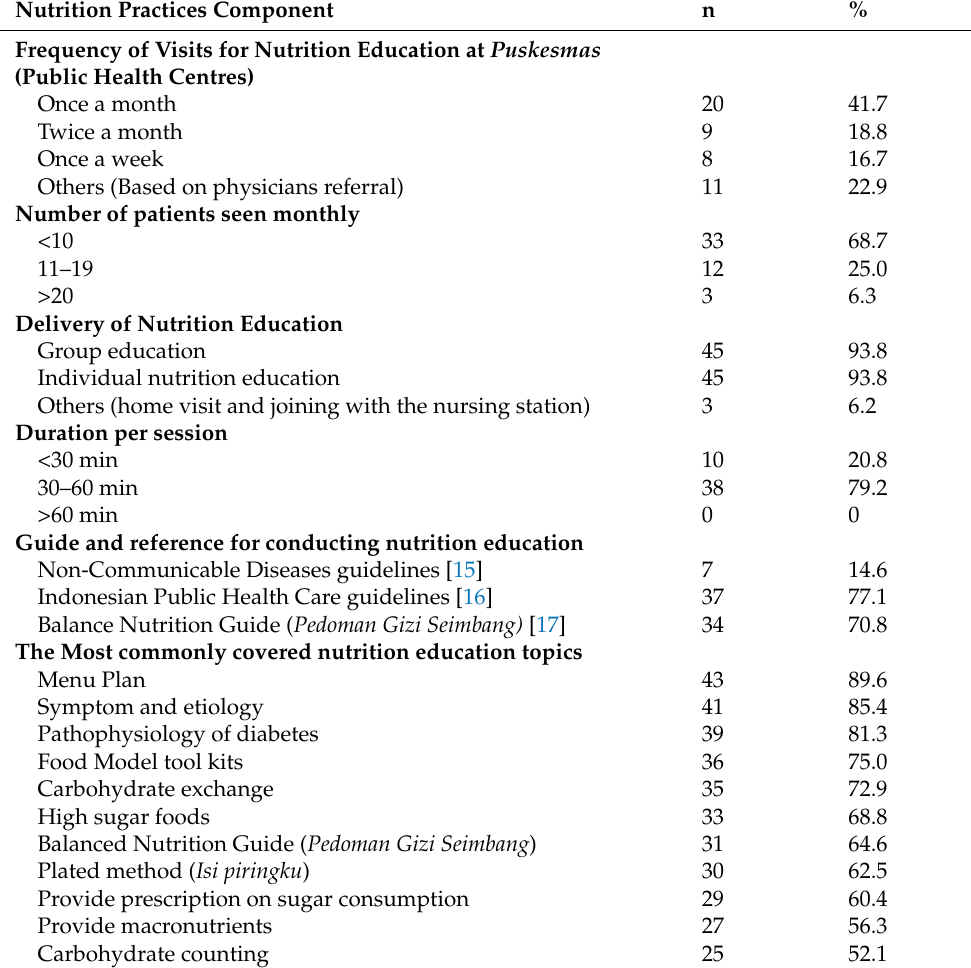
Table 2. Current nutrition practice of the nutritionists at public health clinics (n =